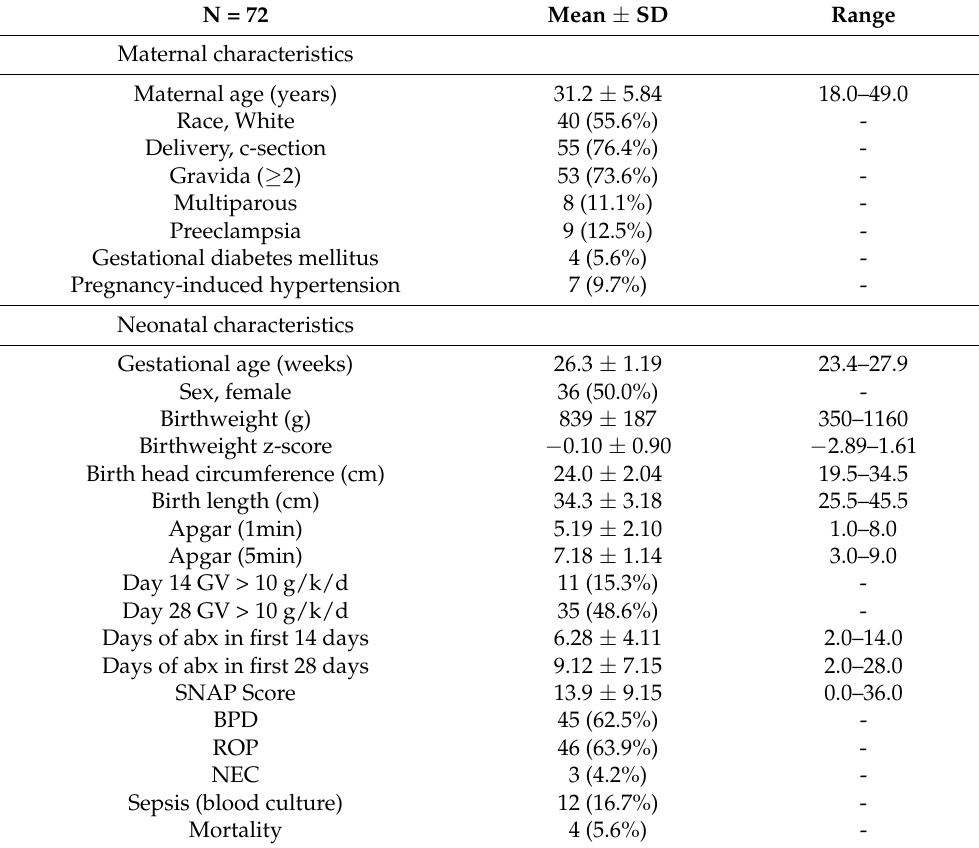
Table 1. Maternal and neonatal characteristics of the study cohort 1